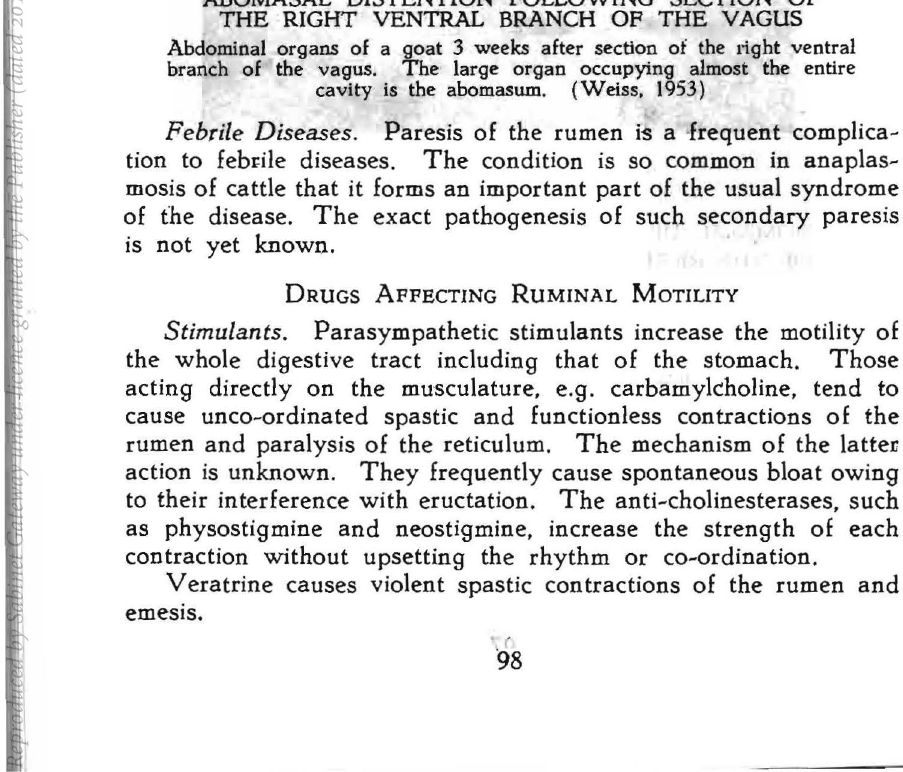
ABOMASAL DISTENTION FOLLOWING SECTION OF THE RIGHT VENTRAL BRANCH OF THE VAGUS Abdominal organs of a goat 3 weeks after section of the light ventral branch of the vagus. The large organ occupying almost the entire cavity is the abomasum. (Weiss.